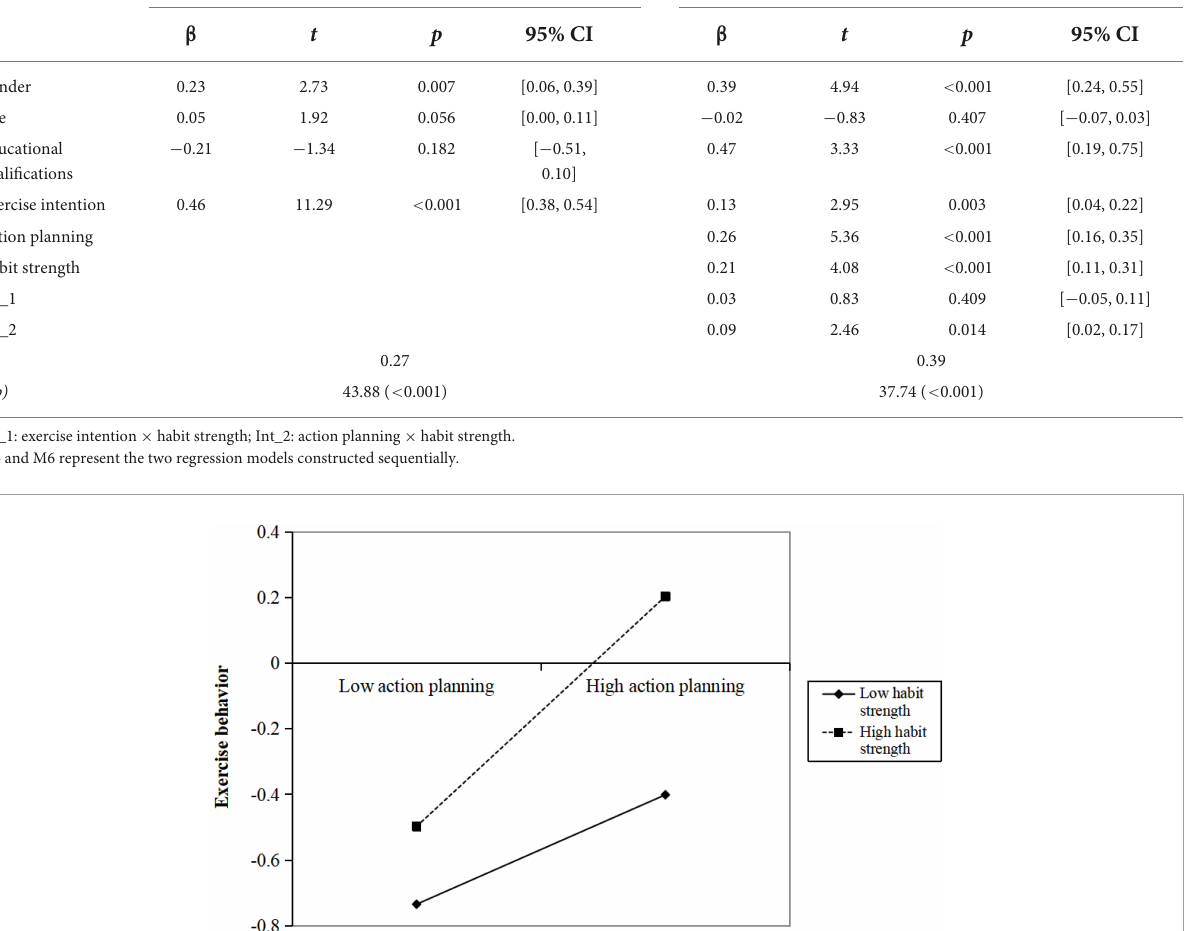
of habit strength and gender by analyzing the